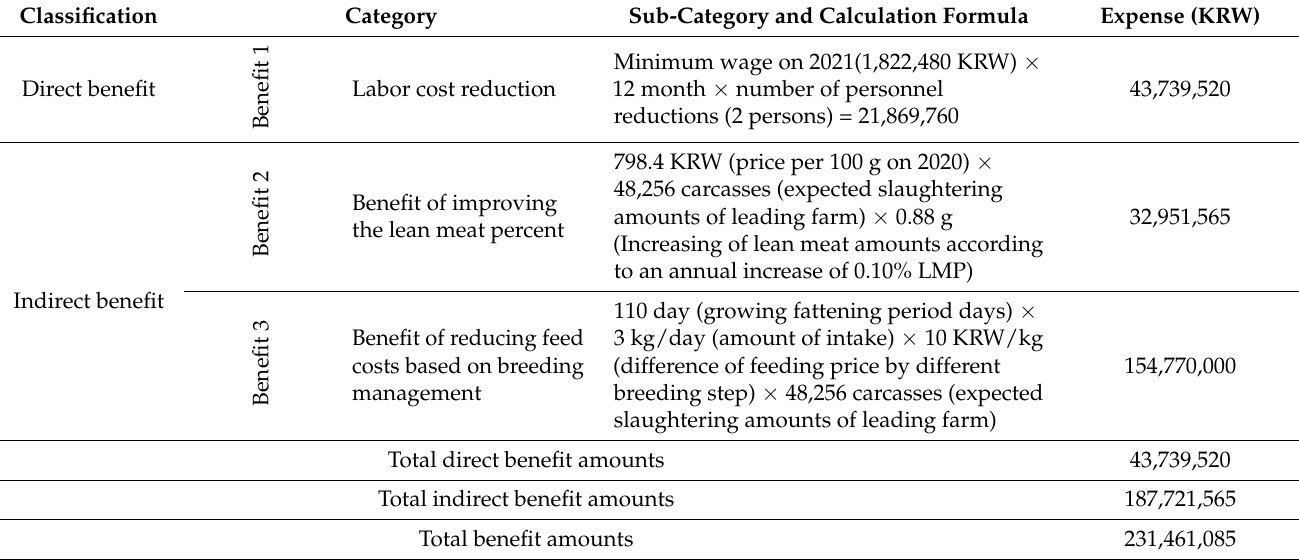
Table 2. Direct and indirect benefits and calculation